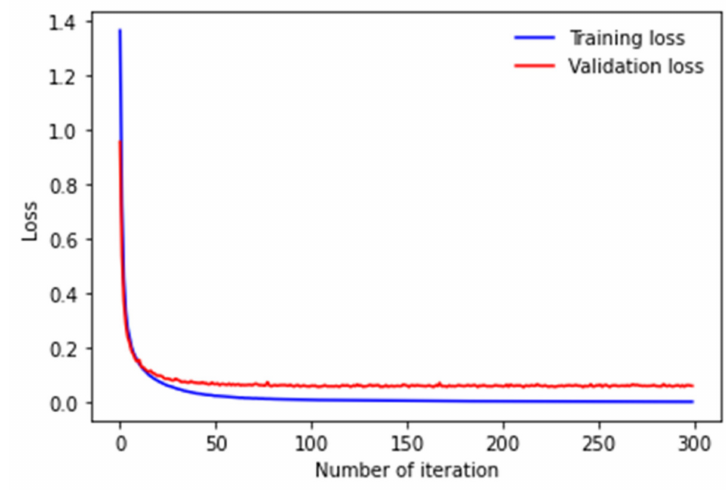
Figure 13. Training and validation learning curves for Softmax activation function.